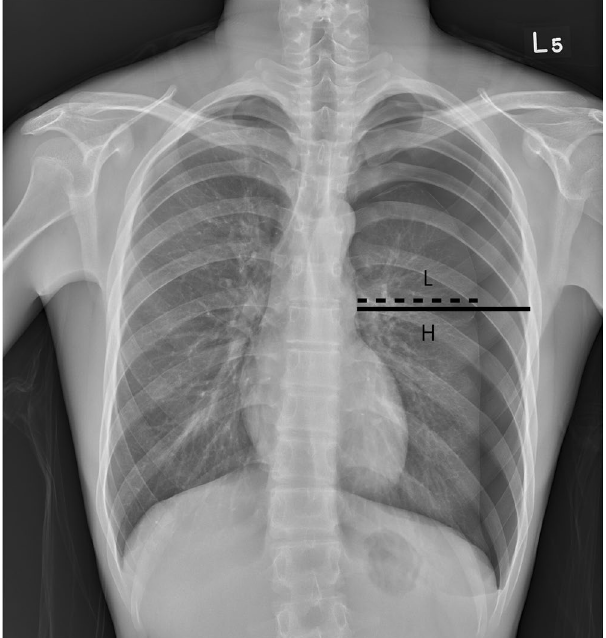
Figure 2. Chest radiograph of a 17-year-old boy with a primary pneumothorax. H represents the diameter of the inner hemithorax at the hilar level, and L represents the diameter of the collapsed lung. Using the Light equation: the size of pneumothorax = (1 − L 3 /H 3 ) × 100%, we can easily calculate an estimated pneumothorax size of